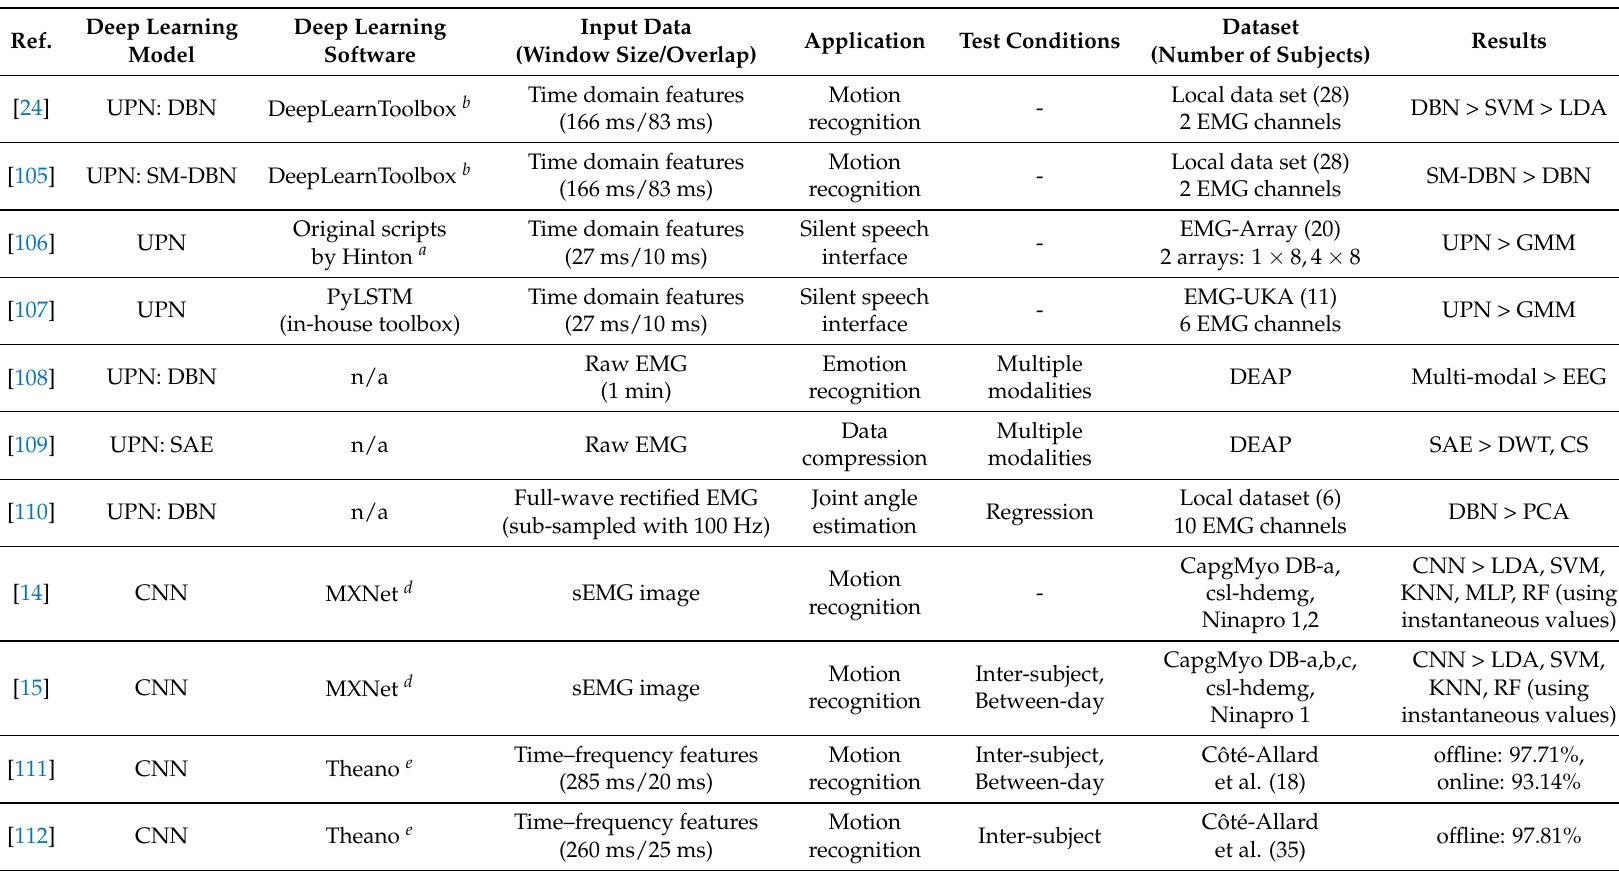
Table 5. Summary of EMG research studies that have used deep learning